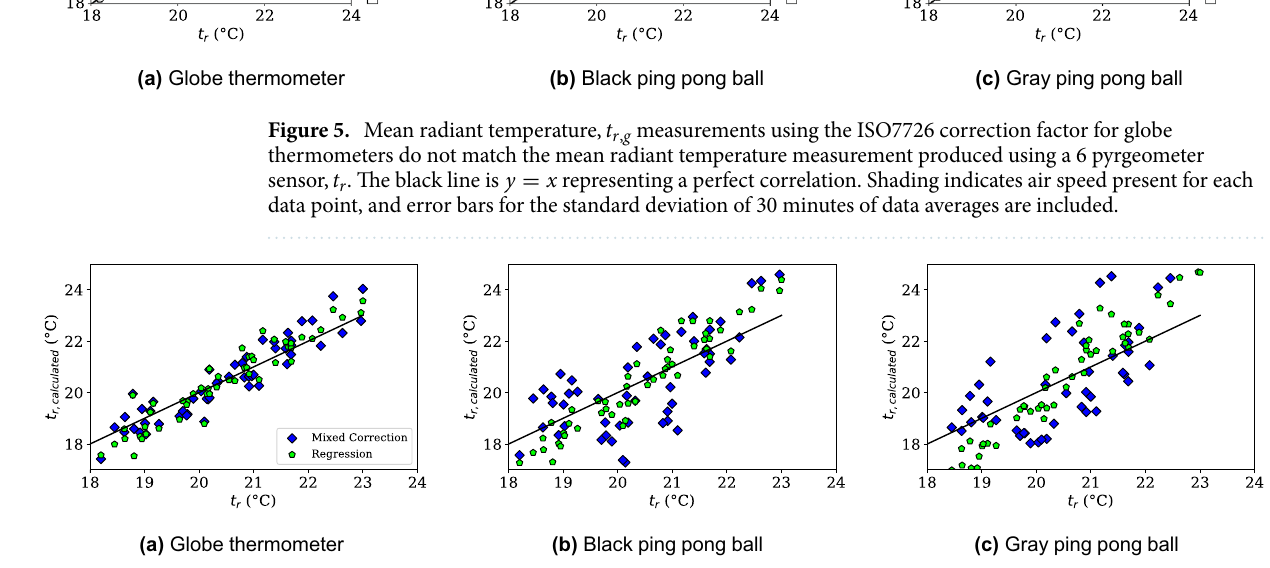
c 1 v a c 2 ( t a t g ) b = + − +